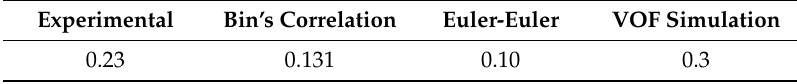
Table 5. Bubbly Plume Penetration Depth(m) at u j = 2.54 m / s and D N = 5 mm.